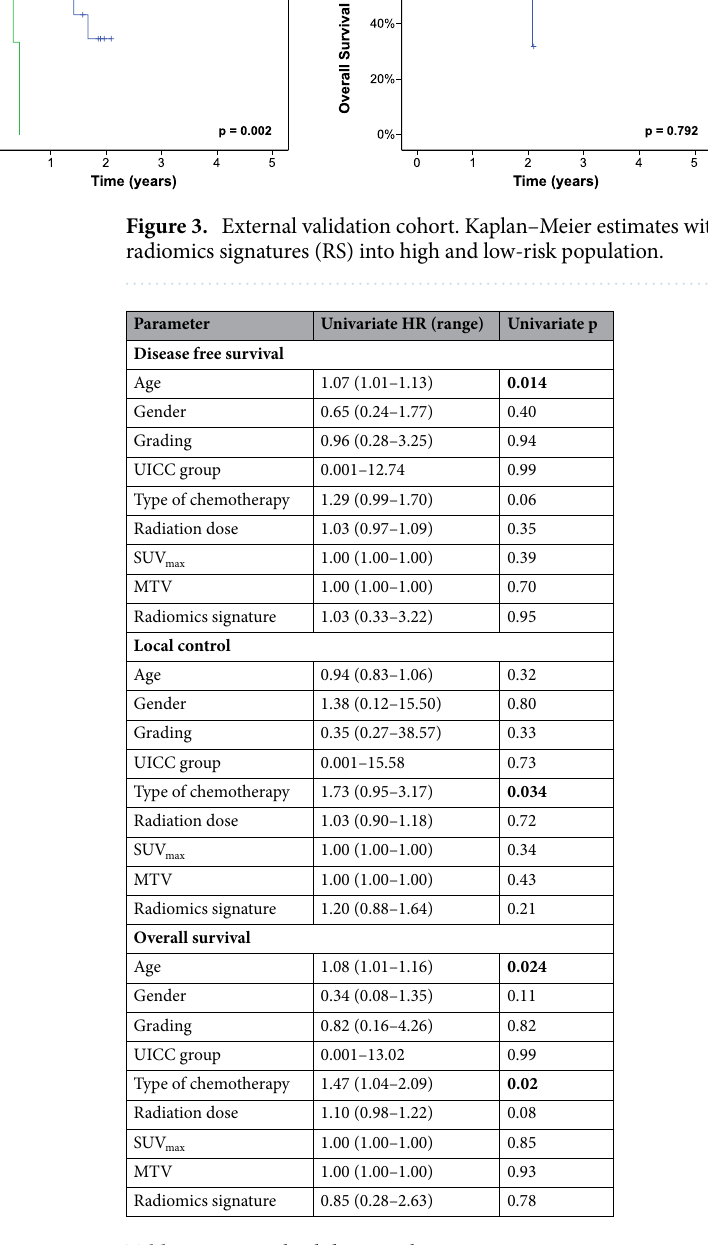
Table 3. External validation cohort. Univariate cox regression analyses of clinical parameters, treatment characteristics, the conventional PET parameter metabolic tumor volume (MTV) and radiomics signatures with respect to DFS, LC and